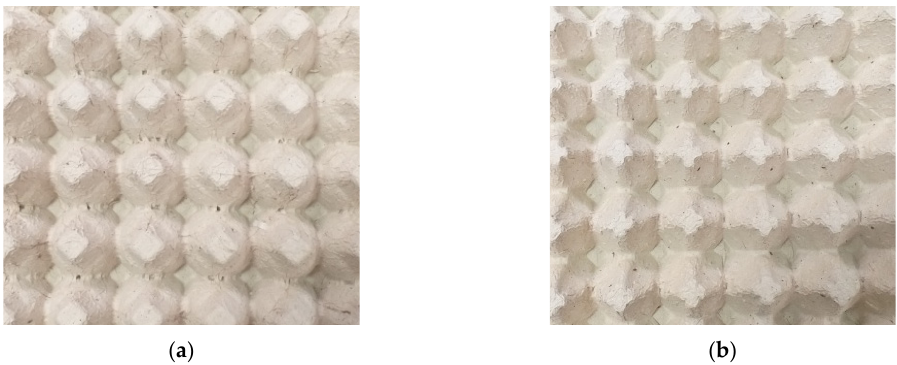
Figure 8. View of a basic tray ( a ) and a modified tray ( b ) assigned to tests.